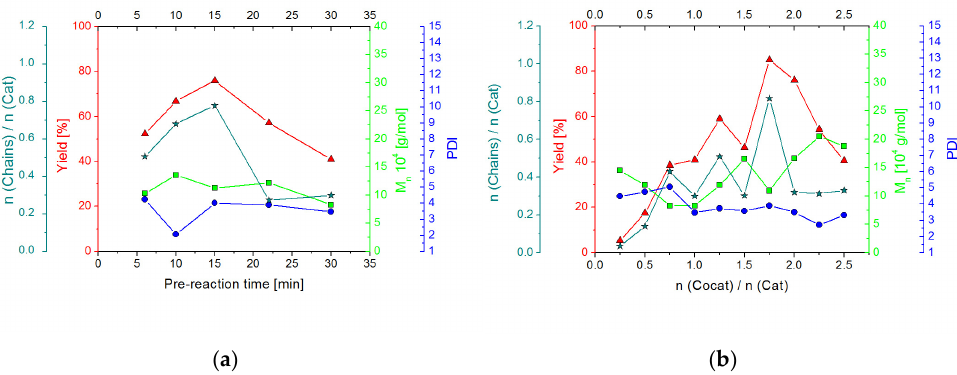
Figure 8. Overview on 1,3 ‐ butadiene polymerization data obtained, when investigating the influence of pre ‐ reaction time (panel a ) and cocatalyst concentration ( b ), applying the catalytic system Nd(AlMe 4 ) 3 ( 2 Nd )/Et 2 AlCl ( E ) with a pre ‐ reaction time of 30 min as an example. The corresponding data are shown referring to four different y ‐ axes: red (yield), green ( M n ), blue (PDI) and teal (extrapolated ratio n(polymer chains)/n(Nd centers)). For details on the calculation of ratios n(chains)/n(Ln centers), see Section S3 of the Supplementary Materials. During these screenings, the polybutadiene microstructure showed a small increase 96.7–98.8% with shorter pre ‐ reaction times and remained constant with higher cocatalyst concentrations until 2.5 equiv. were reached, where it increased to cis / trans /vinylic = 99.5/0.4/0.1% (Figure S1.7.1 and Tables S1.7.1 and S1.7.2, Supplementary Materials). In both panels lines are meant to assist the reader to follow the certain curves within the plot and not to indicate linear behavior of the curves in between the points of measurement.